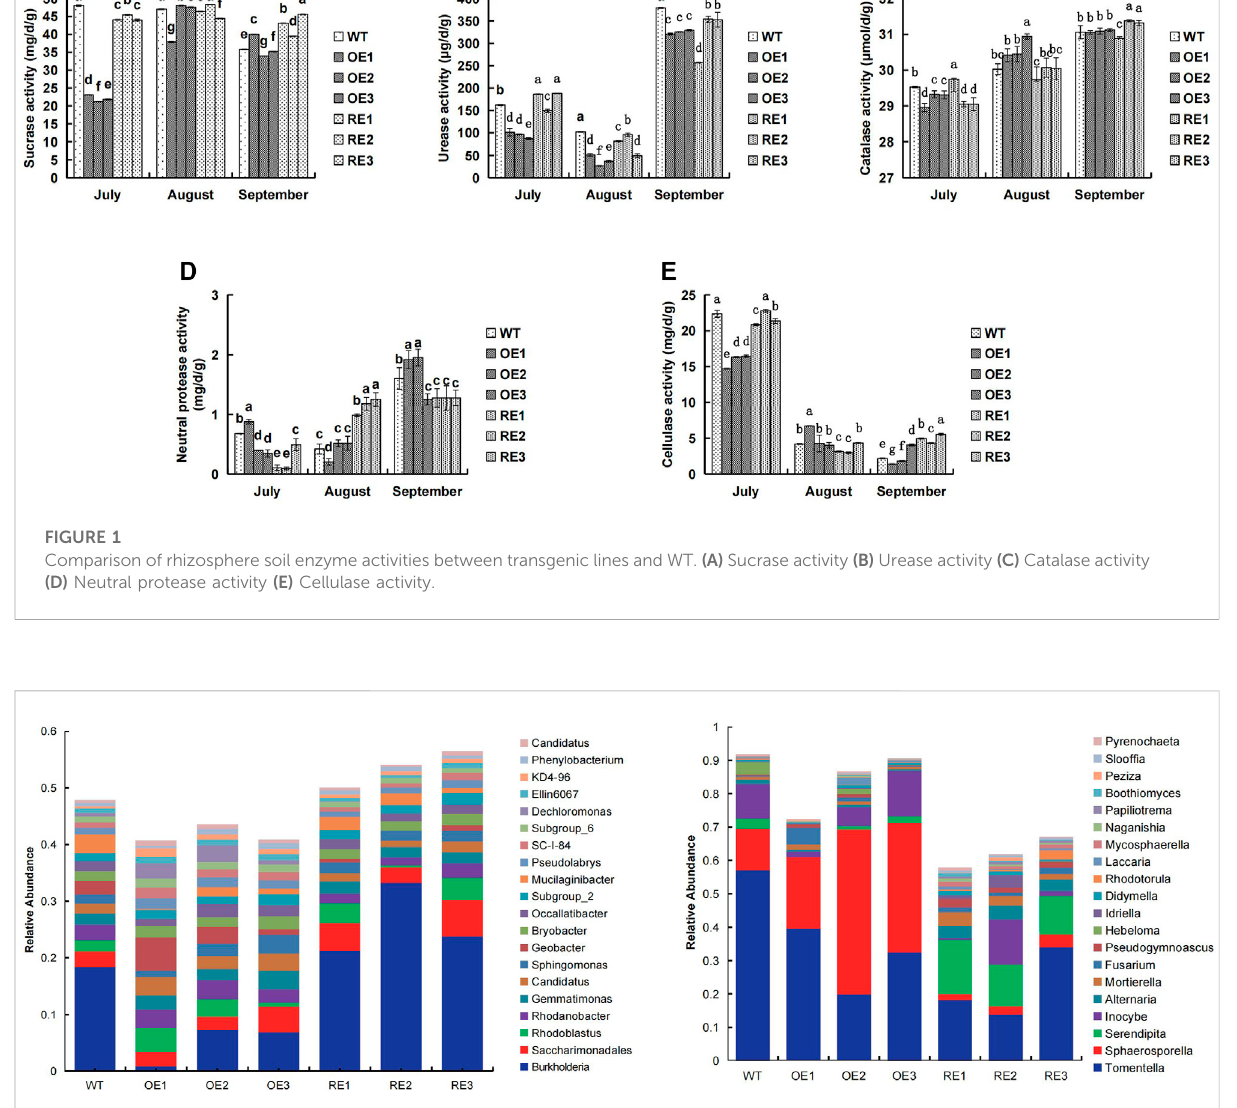
FIGURE 2 Relative abundance of rhizosphere soil microbial communities in populus in the fi rst 20 orders. (A) Bacteria (B)